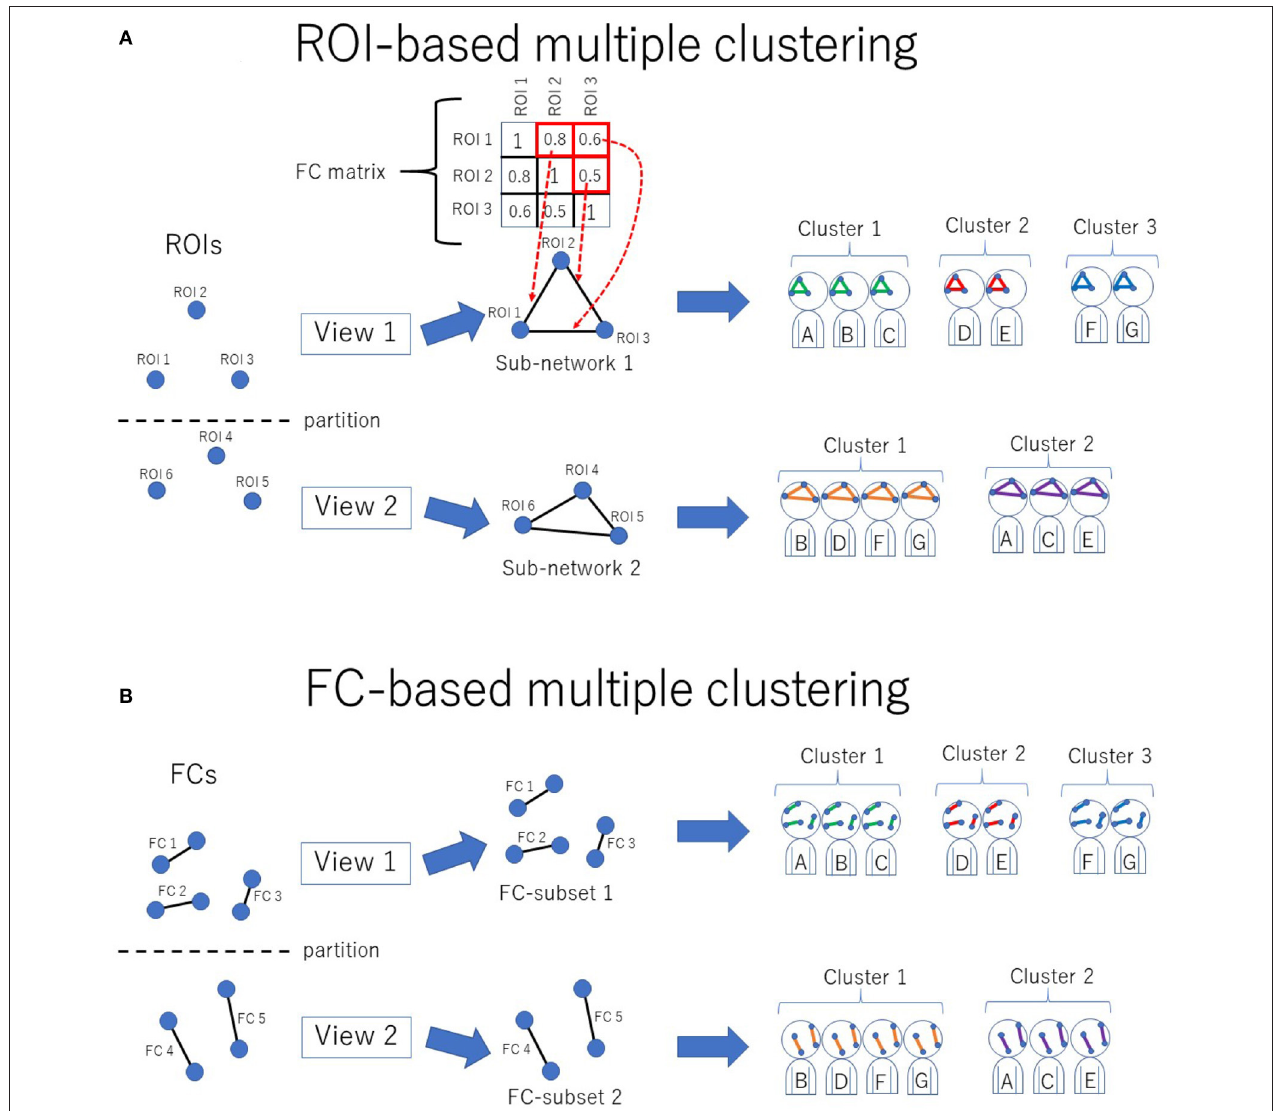
FIGURE 1 | Conceptual illustration of multiple clustering methods. (A) ROI-based multiple clustering method. ROIs are partitioned into several groups (views). In each view, the subject cluster solution is obtained using a particular subset of ROIs (i.e., a subnetwork). The FC matrix represents connectivity within the subnetwork. For instance, in this illustration, the connectivity within view 1 consists of three ROIs, which are denoted by the 3 × 3 FC matrix. This method identifies optimal pairs of subnetworks and cluster solutions, where optimization is performed simultaneously for both the subnetwork and cluster solution. The color in the subnetwork for subjects A–G denotes a cluster-specific pattern of functional connectivity. For simplicity, there are two views in this example. (B) FC-based multiple clustering method. Instead of ROIs, FCs are exclusively partitioned for the subject cluster solutions. This method identifies optimal pairs of subsets of FCs and cluster